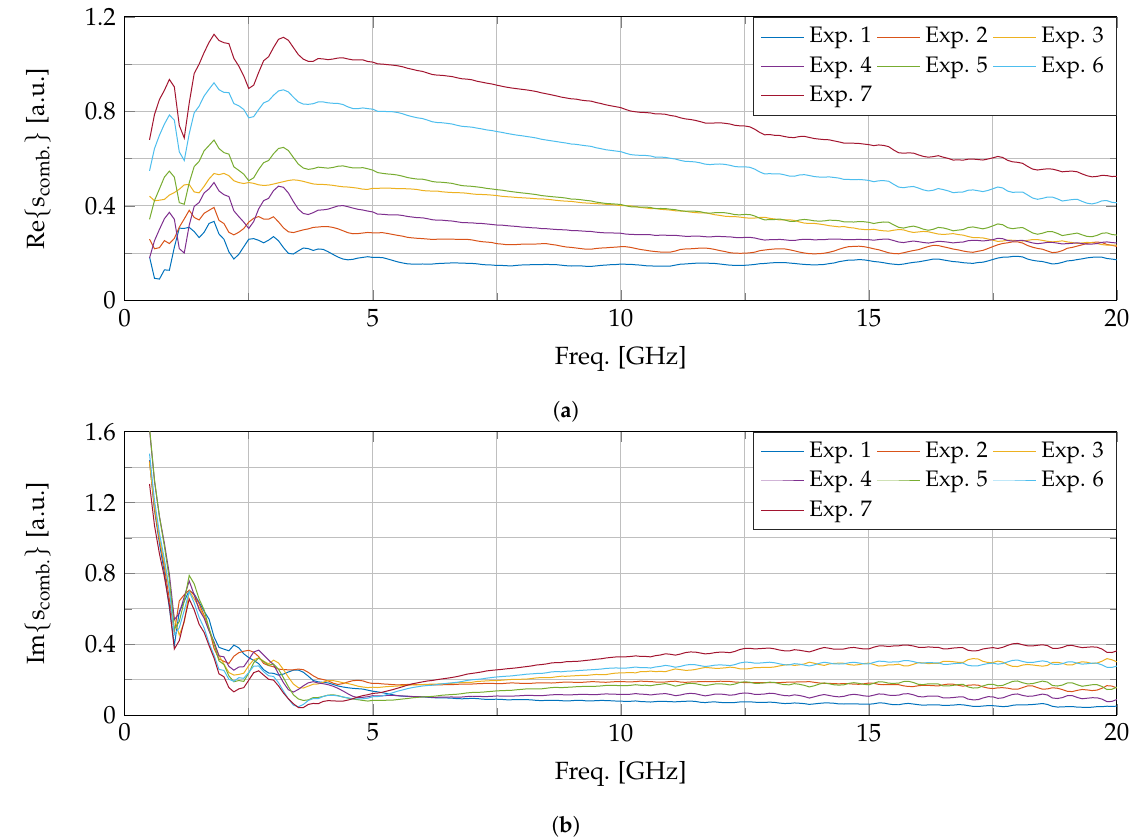
Figure 2. The calculated combined complex uncertainty s comb. for each conducted experiment, the real and imaginary part, in, respectively, ( a , b ). Table 1. Fitted exponential parameters from the pressure-induced exponential decay as shown in Figure 3 with the corresponding goodness of fit value (R 2